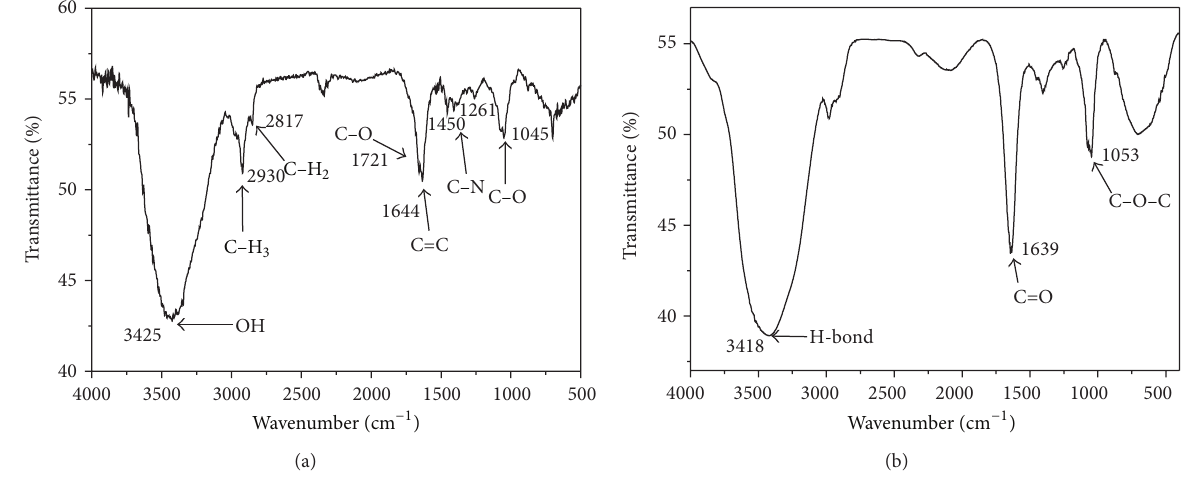
Figure 4: FTIR spectra of (a) chlorophyll dye, (b) anthocyanin dye.